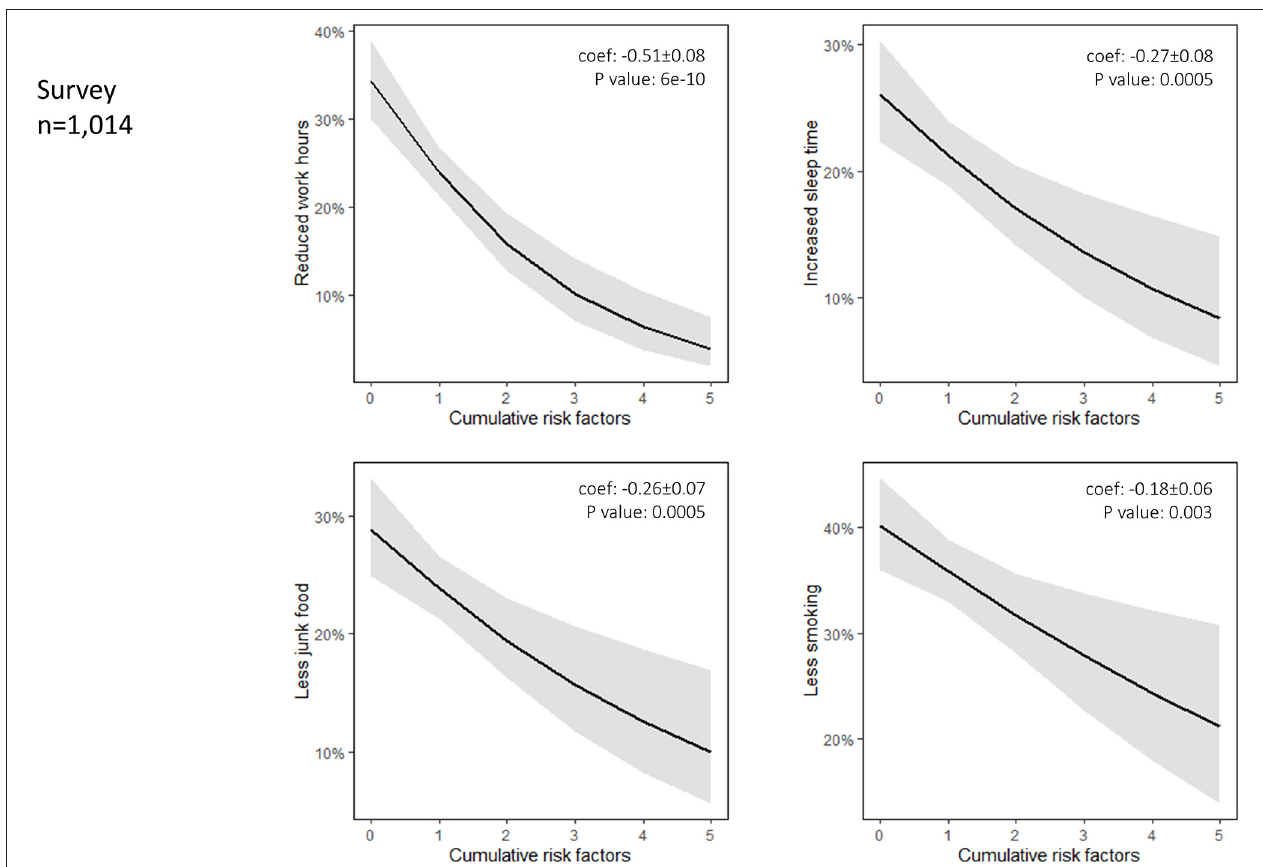
FIGURE 5 | Interaction plot of a logistic regression model denotes an inverse association (negative coefficients) between the observed change in the frequency of the lifestyle habit and the number of registered patient risk factors. Cumulative modifiable risk factors ( n ) registered in the survey and introduced in the logistic regression analysis included smoking, hypertension, diabetes, dyslipidemia, and previous history of coronary artery disease. Reduced working hours, less smoking, less junk food intake, and more sleeping time were reported more frequently in patients with a lower number of modifiable cardiovascular risk